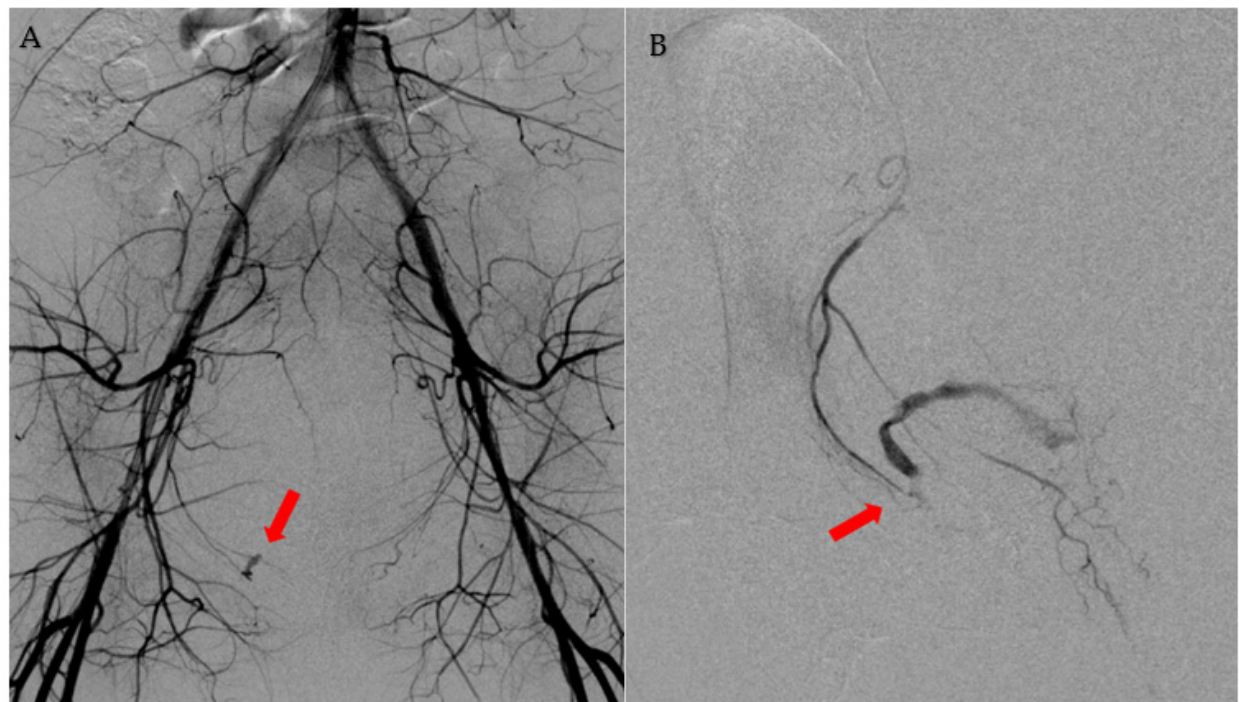
Figure 2. ( A ) Aortography showing active bleeding from the branch of the right pudendal artery (arrow). ( B ) A 1.8-Fr microcatheter is introduced near the bleeding point (arrow). TAE is performed using gelfoam.